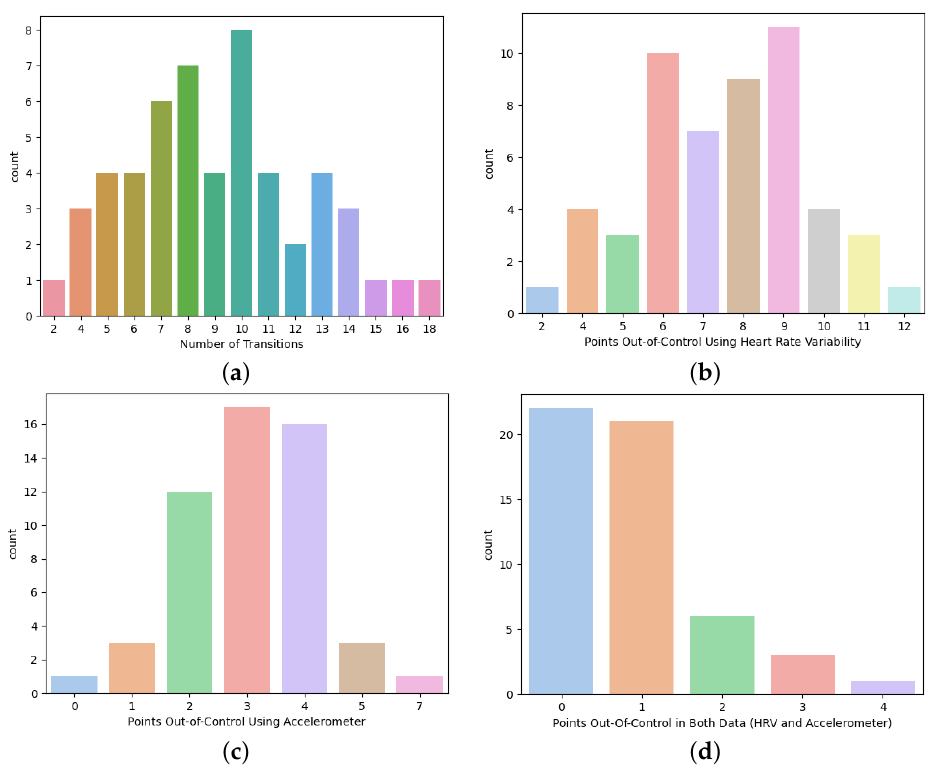
Figure 8. Transitions and Out-of-Control Points ( a ) Number of Drowsiness Transitions. ( b ) Heart Rate Variability Out-of-Control Points. ( c ) Accelerometer Out-of-Control Points. ( d ) Out-of-Control Points in Both Heart Rate Variability and